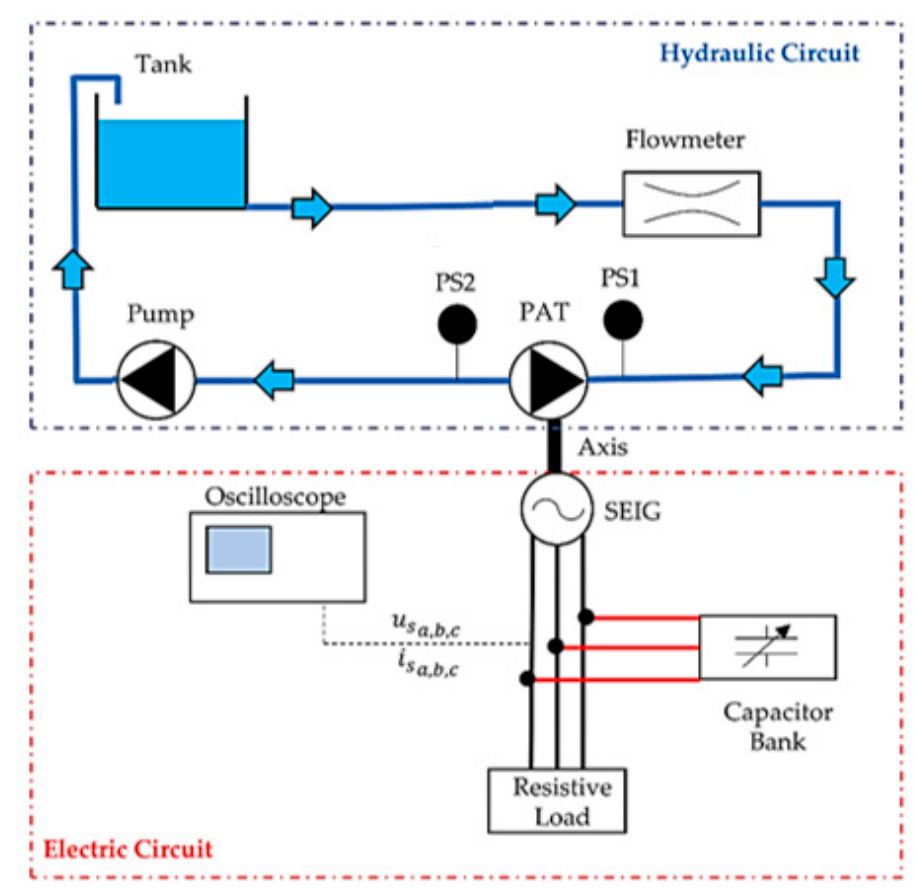
Figure 20. PAT + SEIG scheme with hydraulic and electrical circuits coupled.